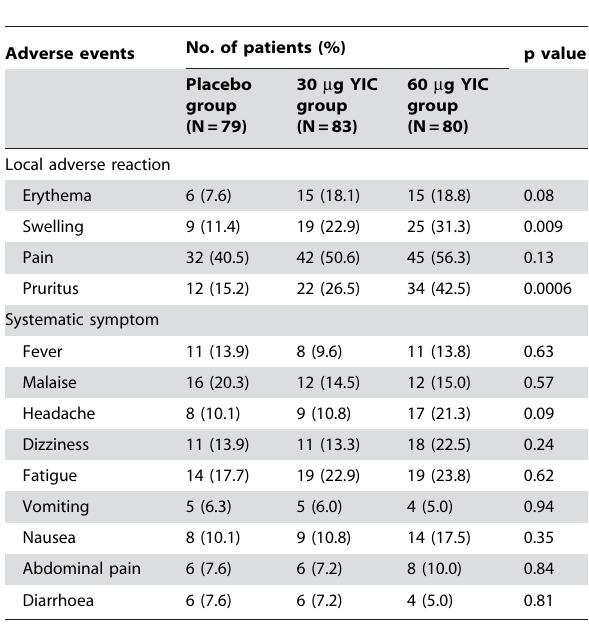
Table 4. Occurrence of most common adverse events during treatment and